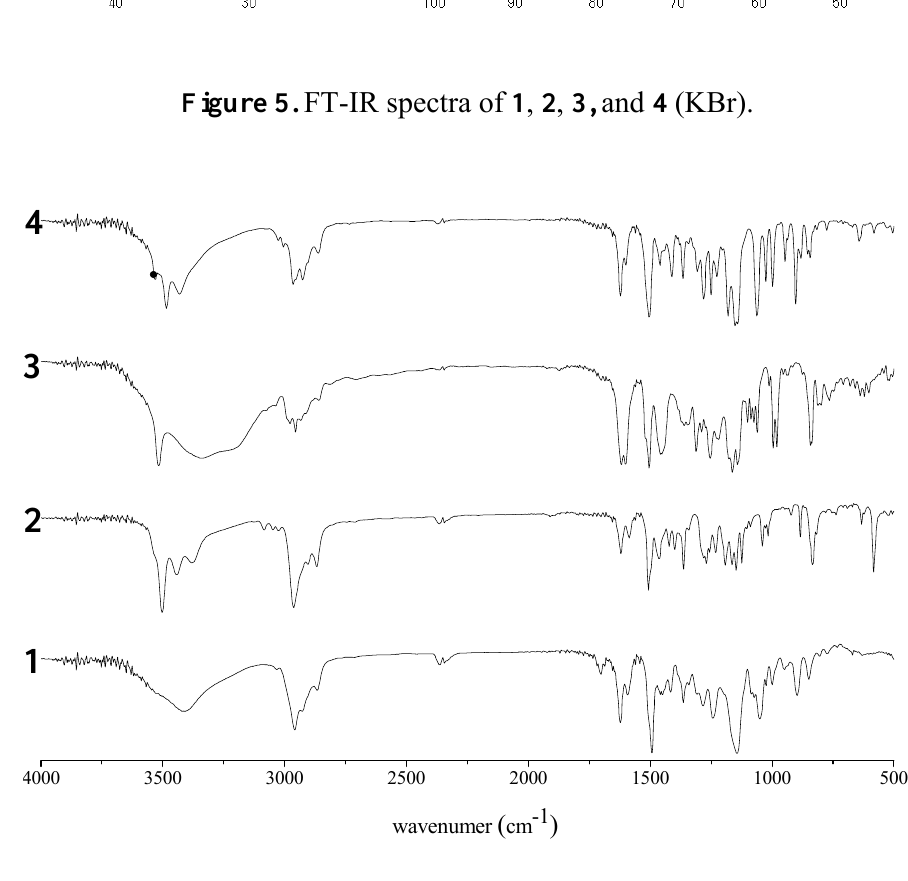
Figure 5. FT-IR spectra of 1 , 2 , 3, and 4